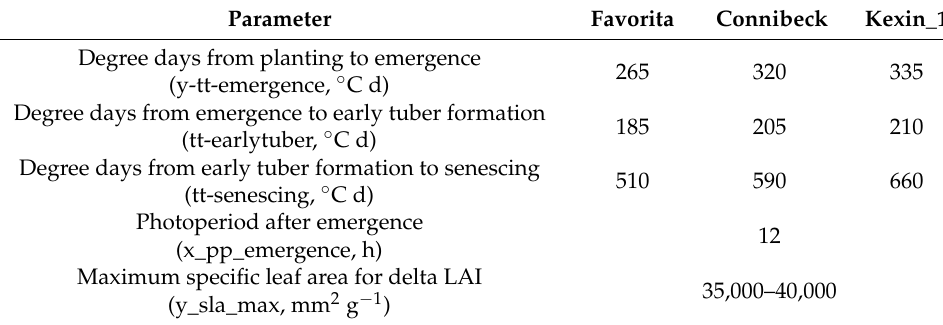
Table 2. Main potato phenology parameters of APSIM-potato.